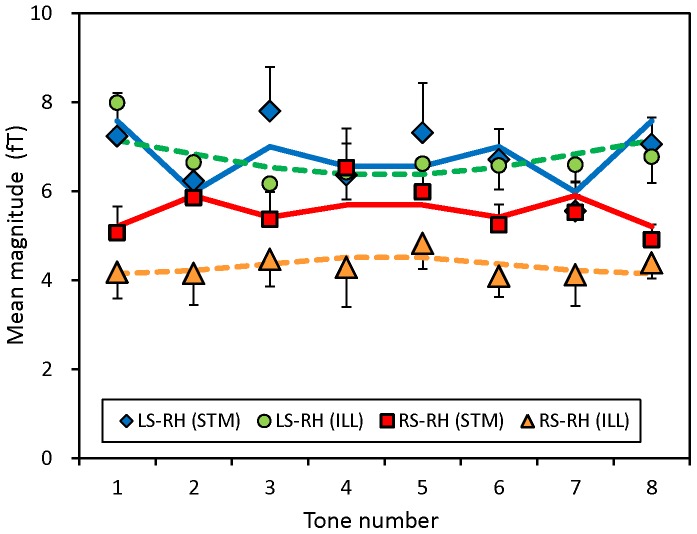
Mean magnitude across subjects of the ASSR of LS (contralateral) and RS (ipsilateral) responses in the RH as functions of stimulus-tone number.Results are shown by symbols for ILL and STM groups (n = 6 in each group), where SE bars are indicated either in the positive or negative direction to avoid overlapping. Calculated dependence is also shown as connected lines that were obtained using single ILL type (broken line) or STM type (solid line) variation of the ASSR (Fig. 3) and multiplying by an appropriate factor to fit the measured values. The calculated values were omitted for clarity.